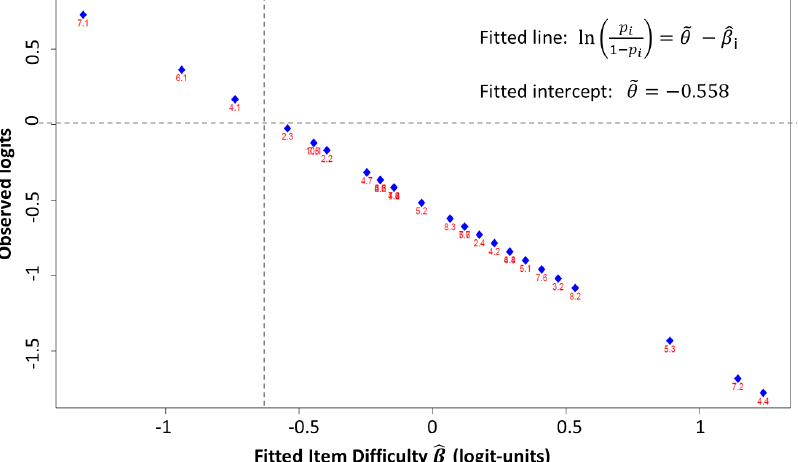
FIG. 4. Rasch calibration of the items in PSCI-ALPHA. Thirty items in field testing fit the Rasch unidimensional model. The observed logits fall on a − 1 slope line. The horizontal dashed line represents the empirical zero-logit level for the 50% item popularity. The ~ θ vertical dashed line marks the intercept with the empirical zero-logit level, at ¼ − 0 . 558 logit, and suggests that the persons in field testing had, on average, less than a 50% chance to solve correctly the entire 30-item set.